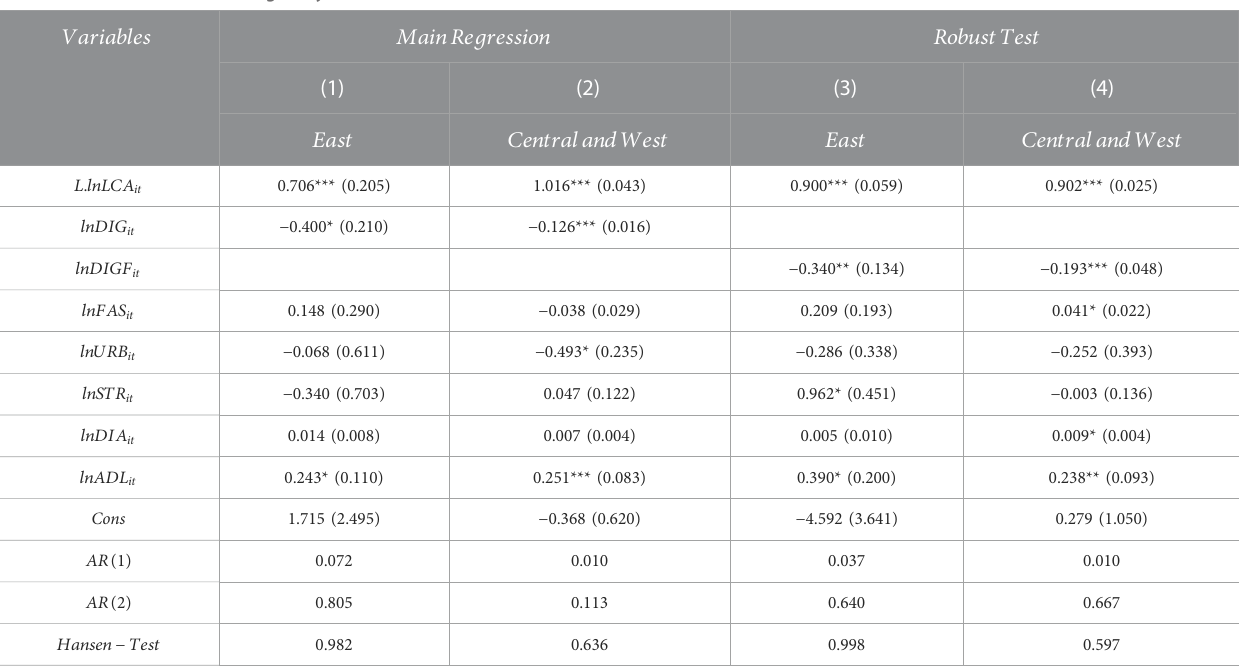
TABLE 6 The results of the heterogeneity test.